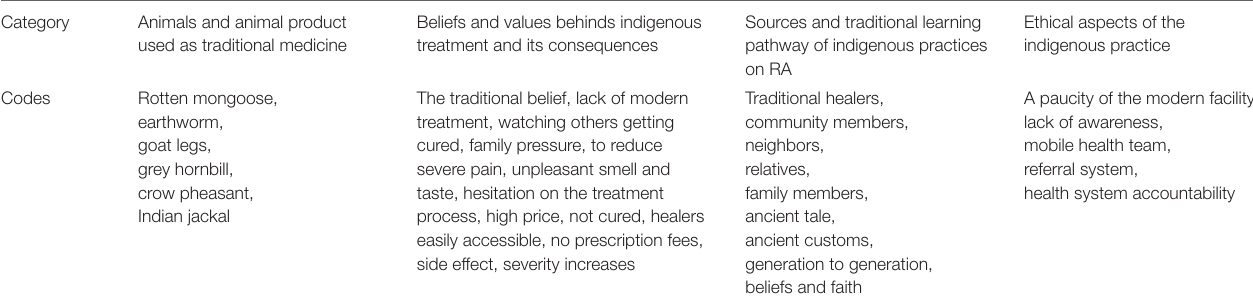
TABLE 1 | Key findings on the use of animals and animal products for the treatment of rheumatoid arthritis in rural Odisha.